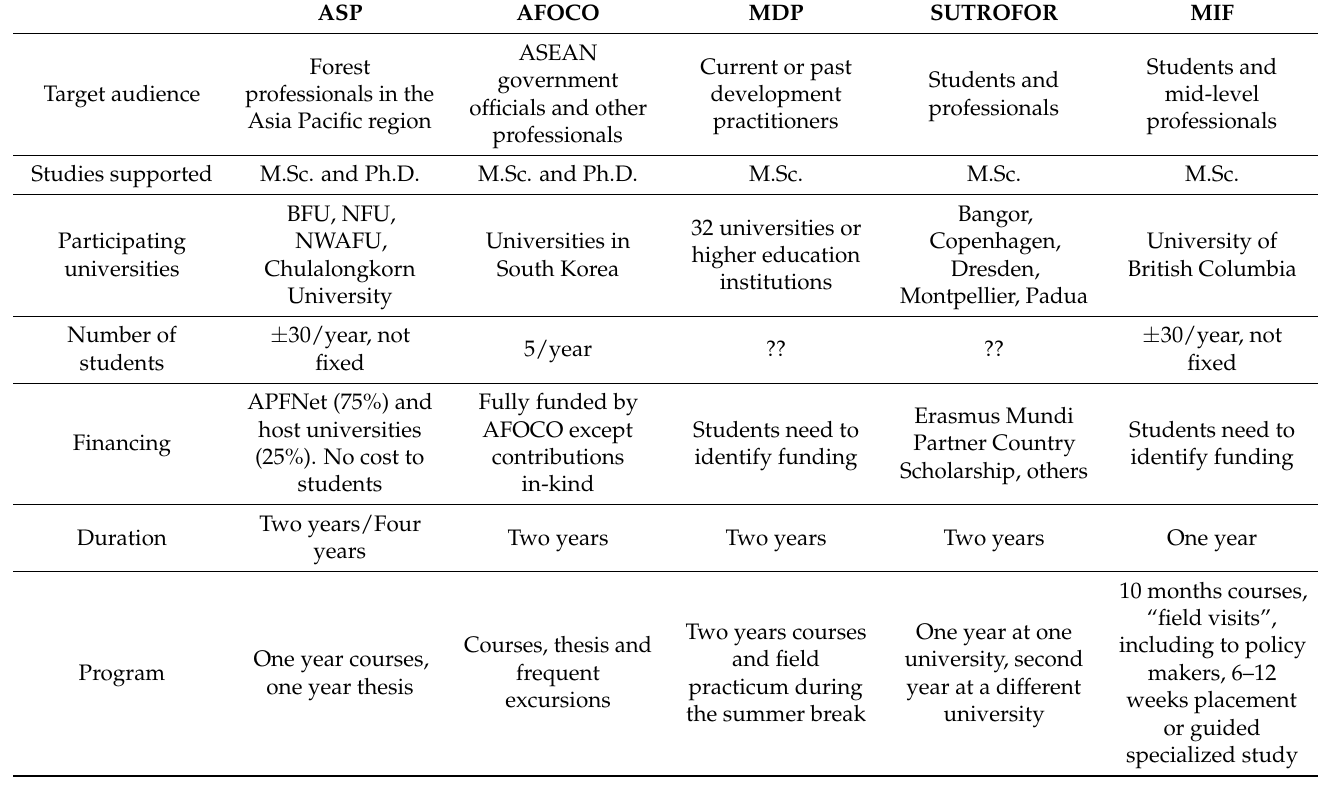
Table 1. A comparison of five forestry continuing education